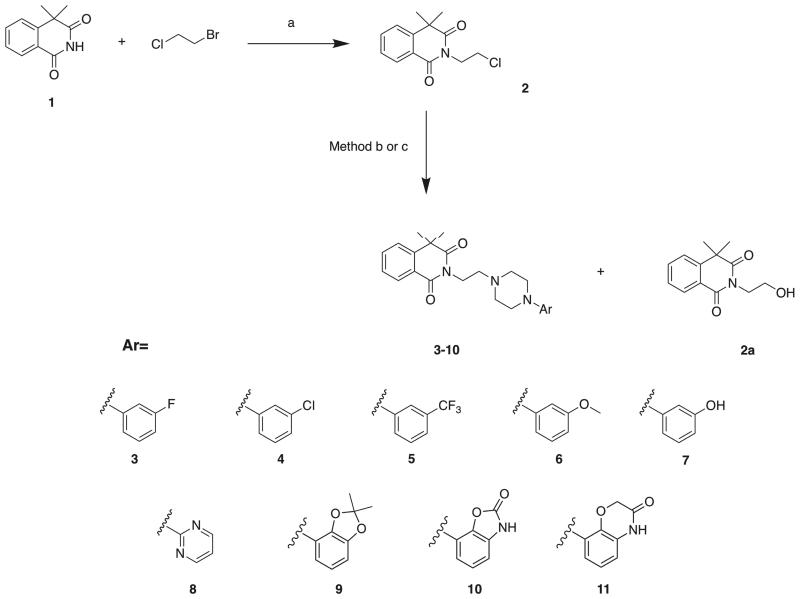
Synthesis of compounds 3–11. Reagents and conditions: (a) TEA, K2CO3, acetone, reflux, 72 h, 60%; Method b: corresponding arylpiperazine, KI, K2CO3, dioxane, reflux, 72 h; Method c: corresponding arylpiperazine, 140 °C, 30 min. Demethylation of 6: BBr3, DCM, 0 °C, 24 h.